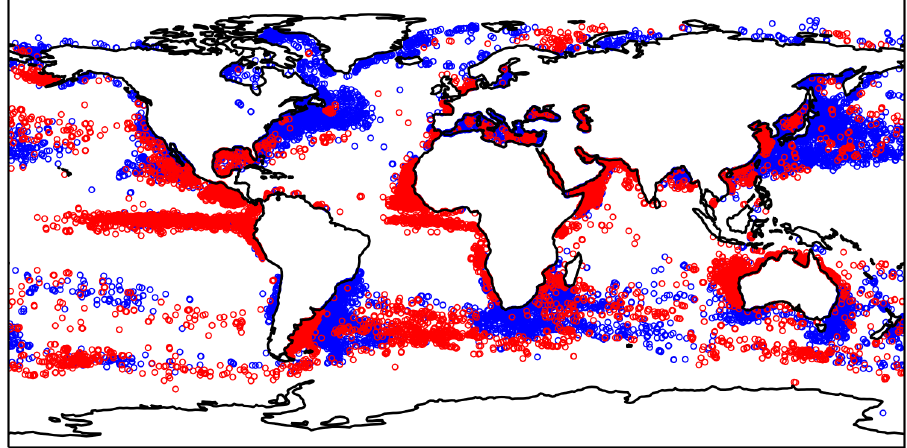
Figure 11. Spatial distribution of the LL 10 /LL 90 cutouts (red/blue) defined as the upper/lower tenth percentiles of the LL distribution for the set of cutouts with ∆ T = [ 2,2.1 ] K. It is evident that these cutouts occupy distinct regions of the ocean; i.e., the ULMO algorithm has identified patterns with significant spatial coherence. More remarkably, note several areas (e.g., in the Brazil–Malvinas current) where one identifies adjacent but separate patches of LL 90 and LL 10